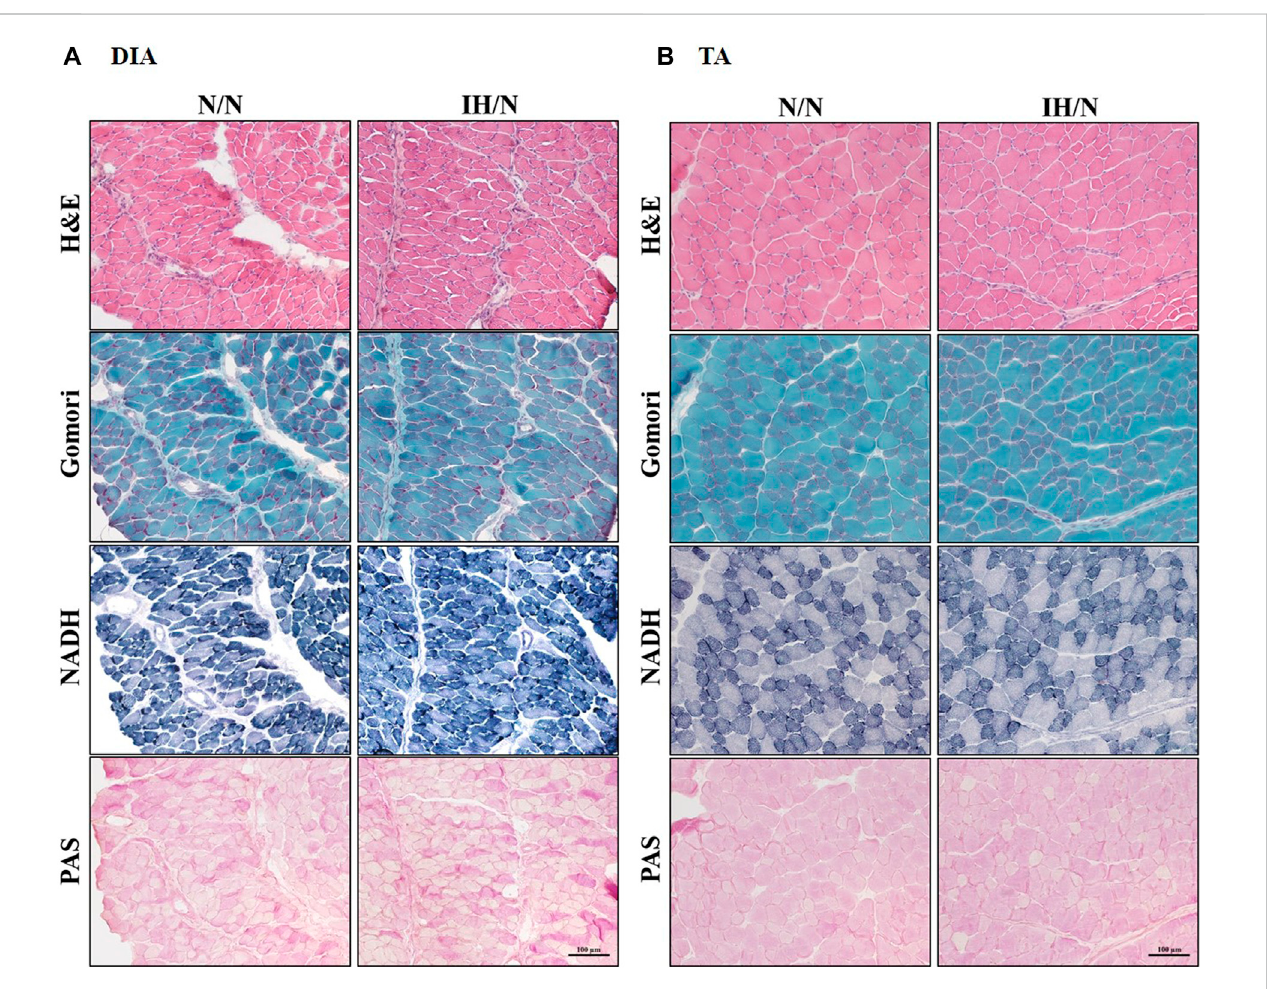
FIGURE 2 Histological images from the DIA and TA muscles of offspring rats. Histological images of H&E, modi fi ed Gomori Trichrome, NADH, and PAS staining showed no pathological features in the (A) DIA, and (B) TA muscles from N/N and IH/N